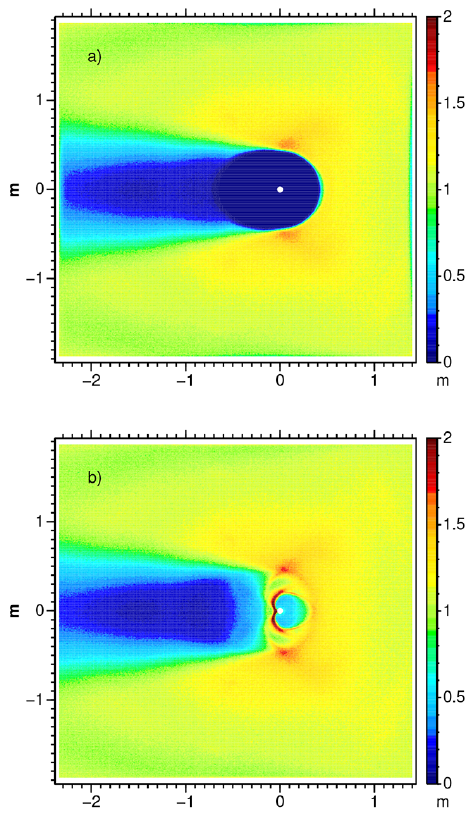
Figure 3. Electron density (a) and ion density (b) normalised to plasma-stream density in the final state ( t = 2 . 43ms) of run Base- line.